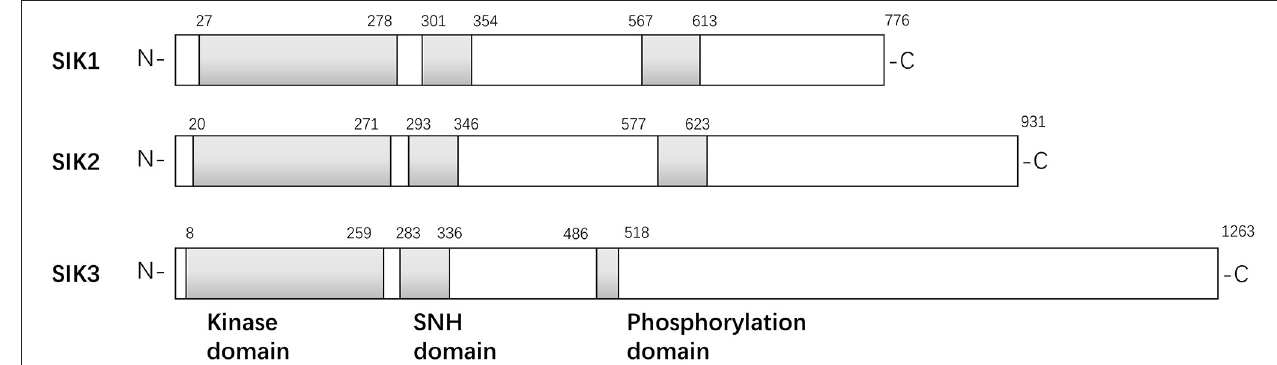
FIGURE 1 | Structures of isoforms in SIK family.